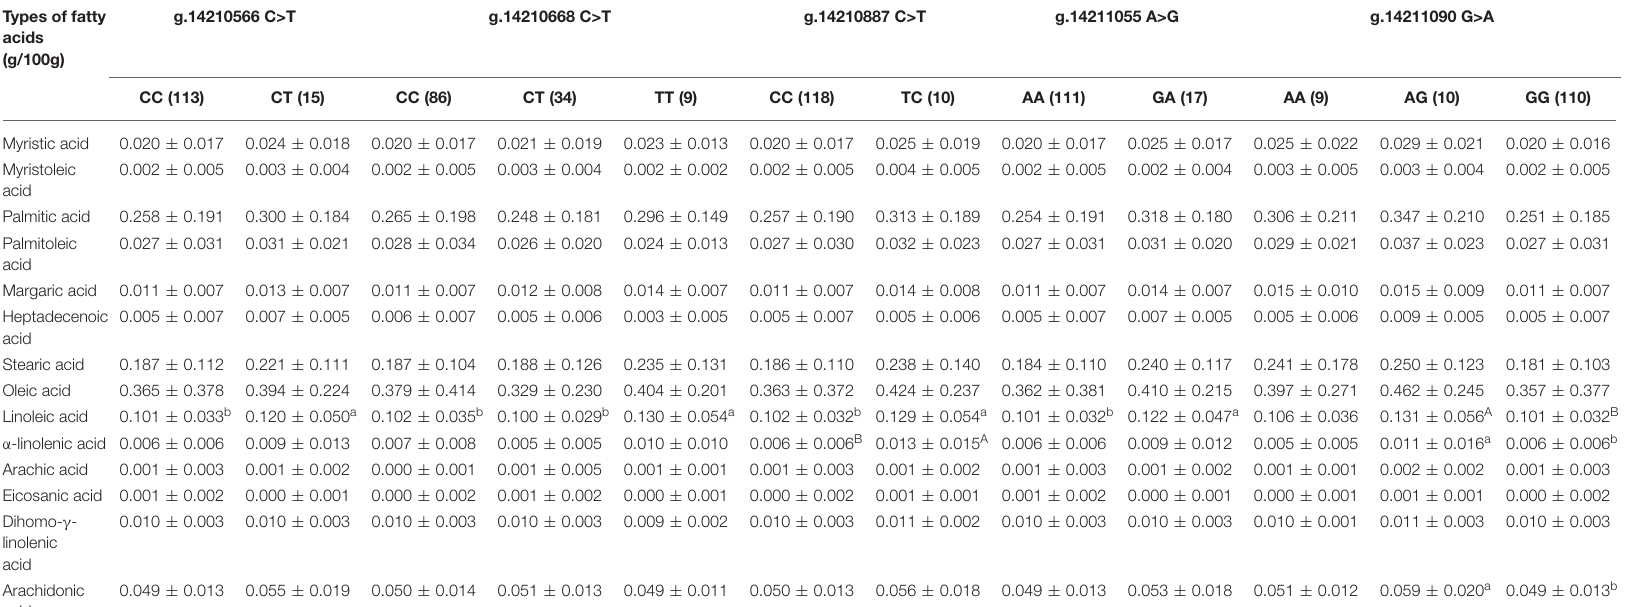
TABLE 3 | Association analysis of five SNPs in the second exon of ACSF3 gene and fatty acids in Chinese Simmental Cattle. Types of fatty acids